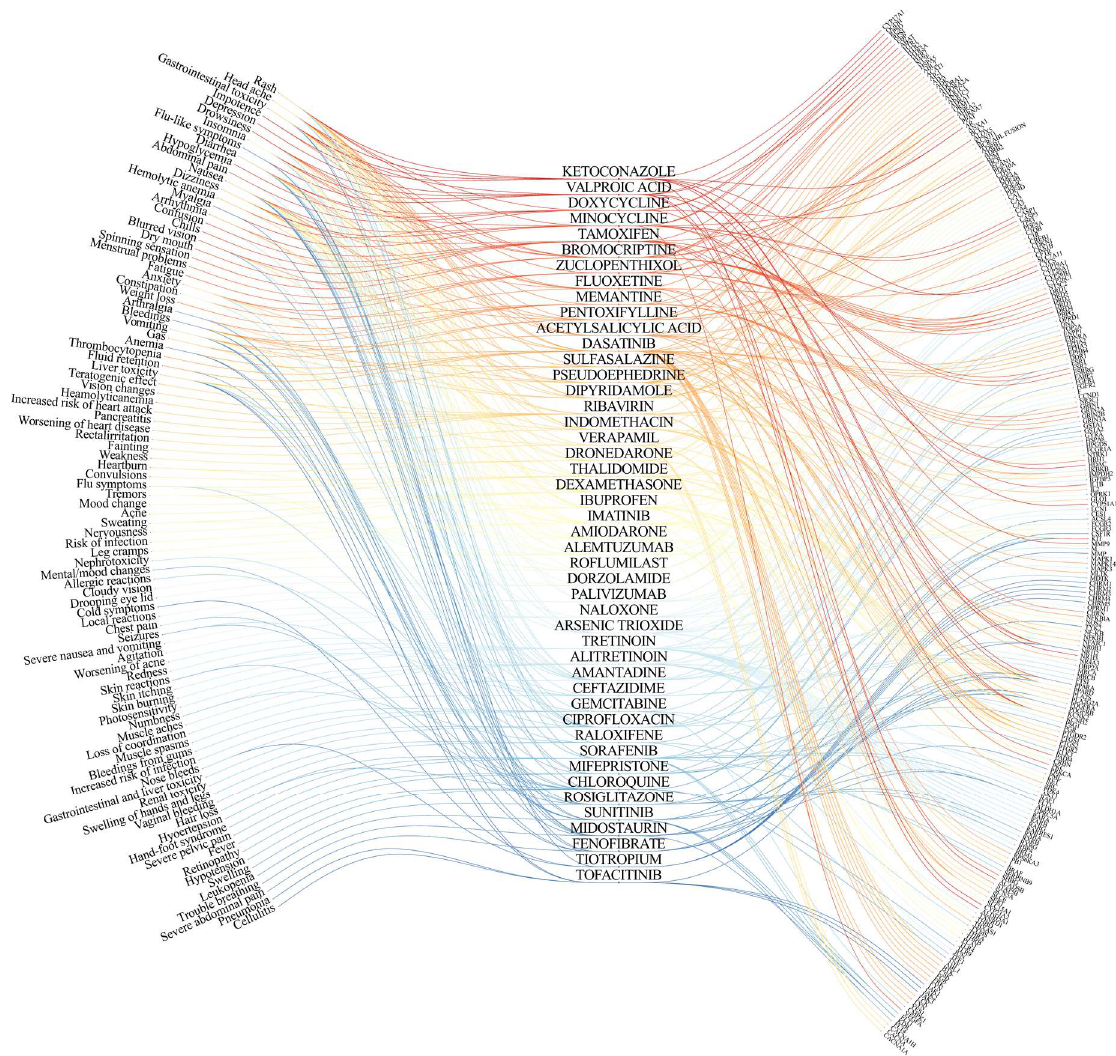
Figure 1. Eye diagram linking antiviral agents (middle) with their side effects (left) and targets (right). The information on drug targets and side effects were retrieved from DrugBank (www.drugbank.ca). Antiviral agents with four or more links to targets or side effects are shown.